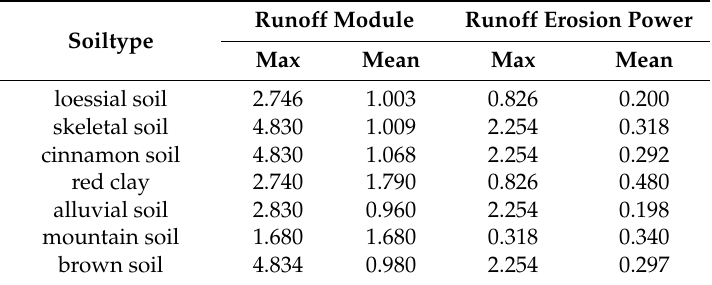
Table 3. Runoff Erosion capacities of different soil types in the Xihe River Basin. The units of